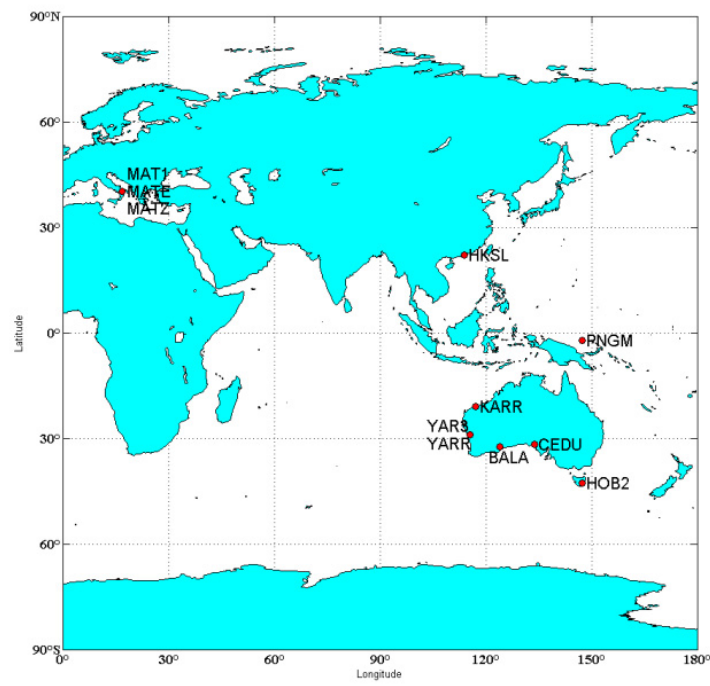
Figure 1. Geographic distribution of stations used in the global positioning system (GPS) / BeiDou